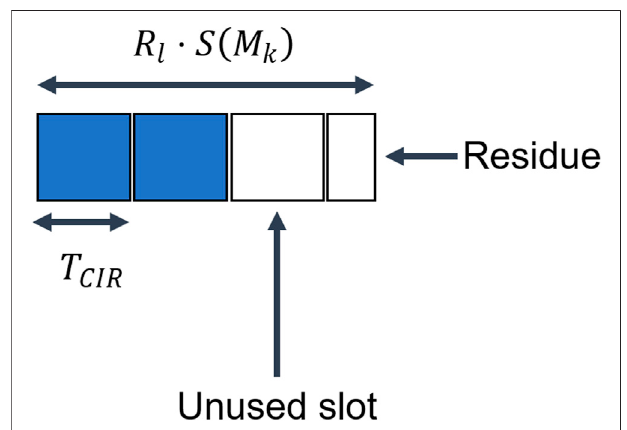
FIGURE 3 | Representation of carrier slots for a C k,l